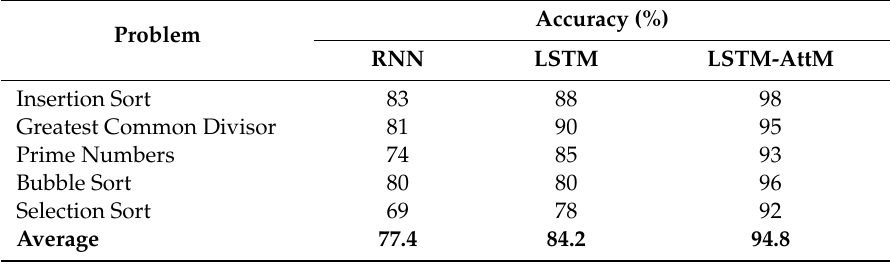
Table 4. Assessment results of syntax error detection for erroneous source code.